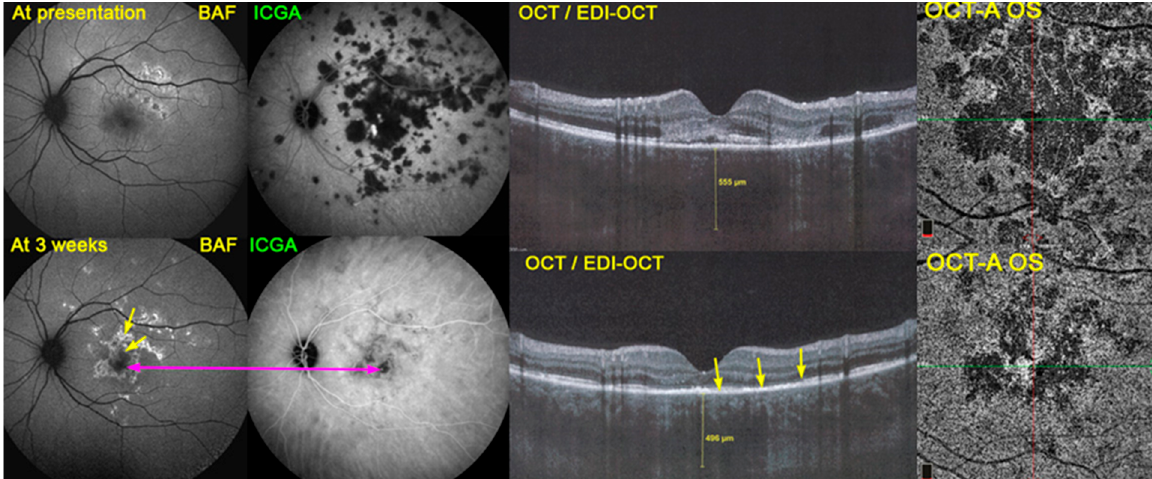
Figure 1. Multimodal imaging in APMPPE combining BAF, ICGA and OCT/EDI-OCT. This combination of invasive (ICGA) and non-invasive methods (BAF and OCT/EDI-OCT) gives a precise appraisal of the condition. BAF at presentation ( top left ) still showed minimal changes despite the extensive choriocapillary non-perfusion shown on ICGA (top middle), because the overlying RPE and outer retina were still at an edematous stage, as shown on OCT/EDI-OCT ( top right ). Three weeks later, after the partial re-perfusion seen on ICGA ( bottom middle ), the damaged areas were visible on BAF ( bottom left ). In the center, there was hypoautofluorescence corresponding to remaining non-perfusion on ICGA (crimson arrow). The bright hyperautofluorescent areas correspond to both suffering RPE cells with accumulated fluorophores and to the loss of photoreceptor outer segments, as shown on OCT/EDI-OCT ( bottom right ) (yellow arrows). OCT-A did not yield additional information, showing the same non-perfusion areas as seen on ICGA (choriocapillary drop out), limited to the central macular area, but was useful in the follow-up of these central damaged areas (also see Figure 3). (Far-right) OCT-A images at presentation ( top right ) and after 3 weeks ( bottom right ).